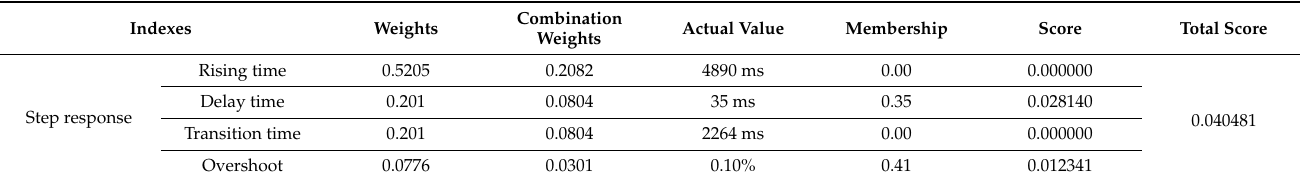
Table A5. PID controller displacement curve Evaluation table.